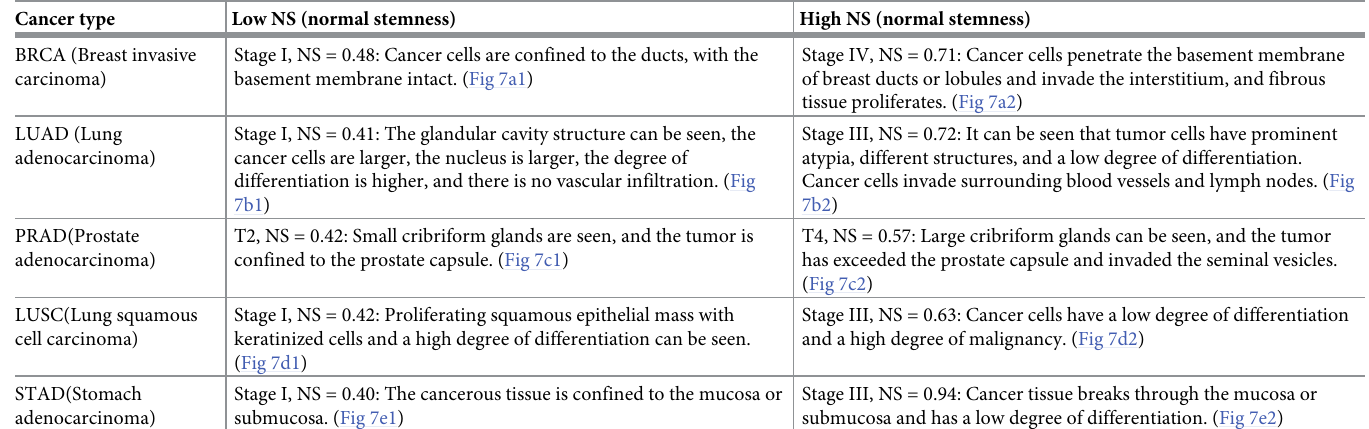
Table 3. The sample discrete value table of TCGA clinical-stage data. Cancer type Low NS (normal